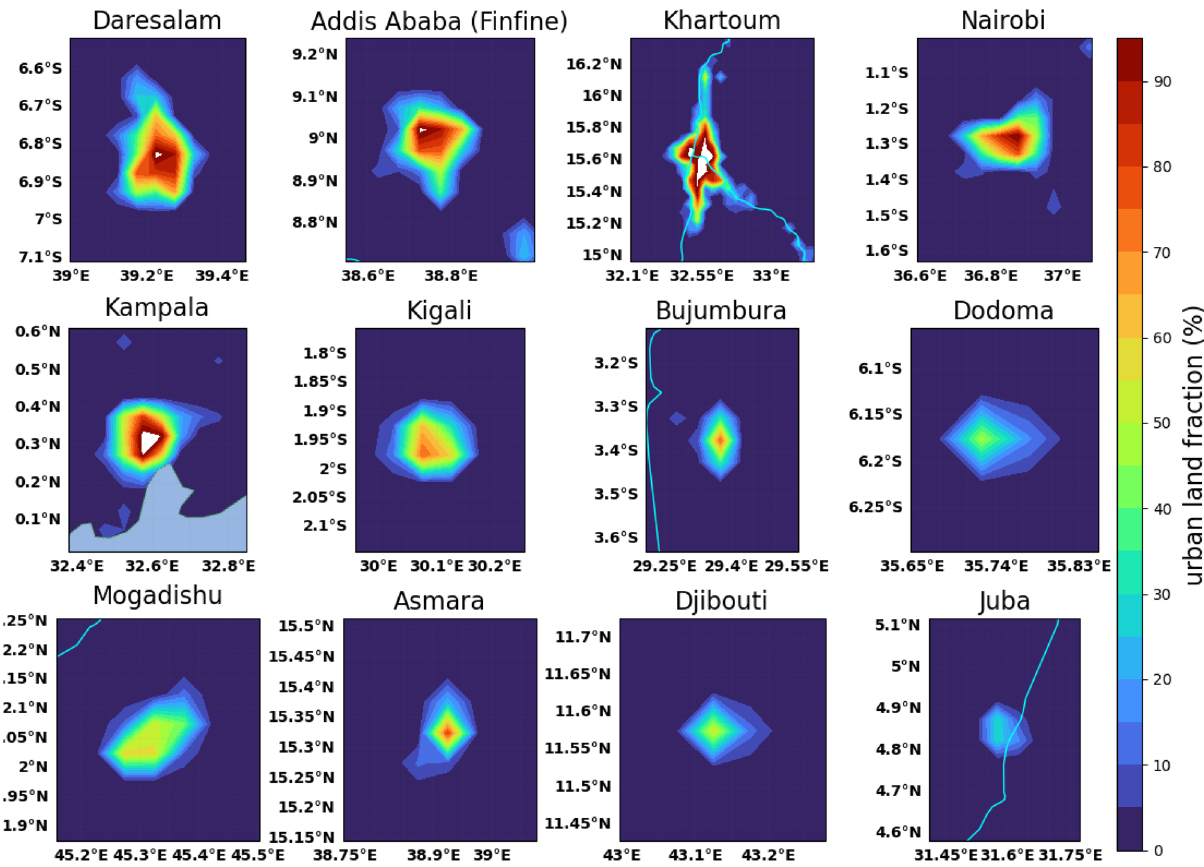
Figure 2. Urban land fraction around the capital cities in the greater horn of Africa